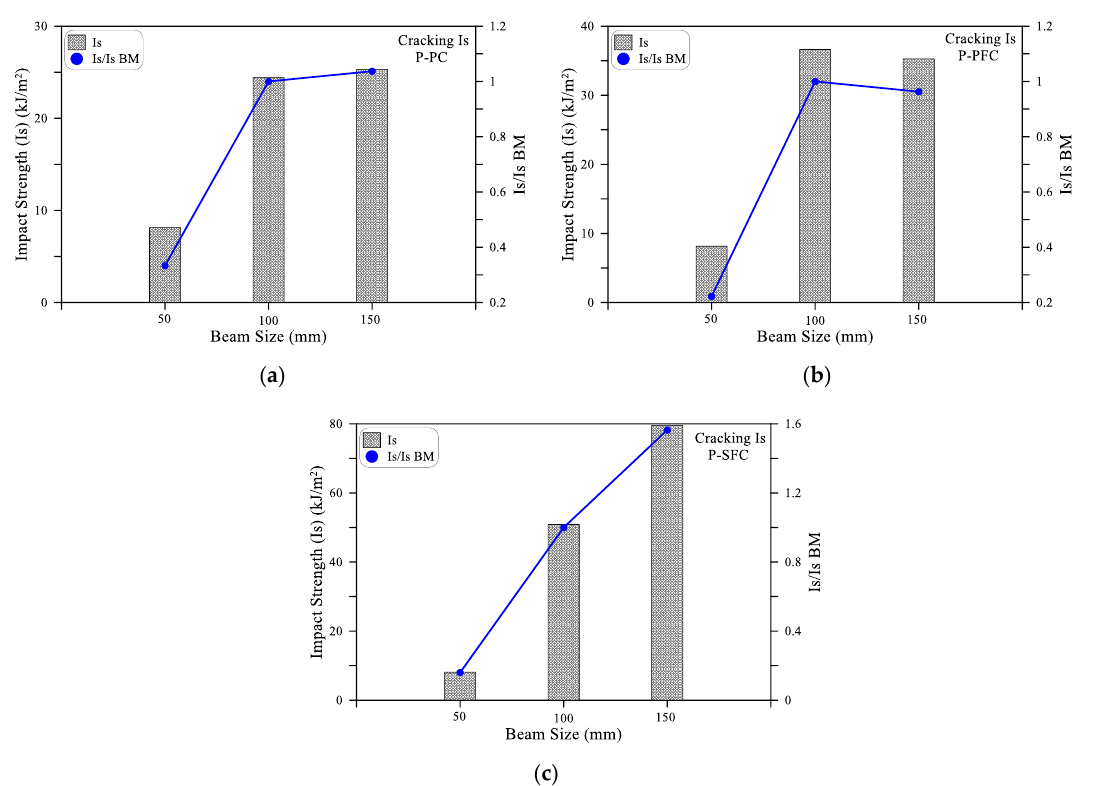
Figure 12. Cracking impact strength of the three beam sizes: ( a ) PC; ( b ) P-PFC; ( c ) P-SFC.